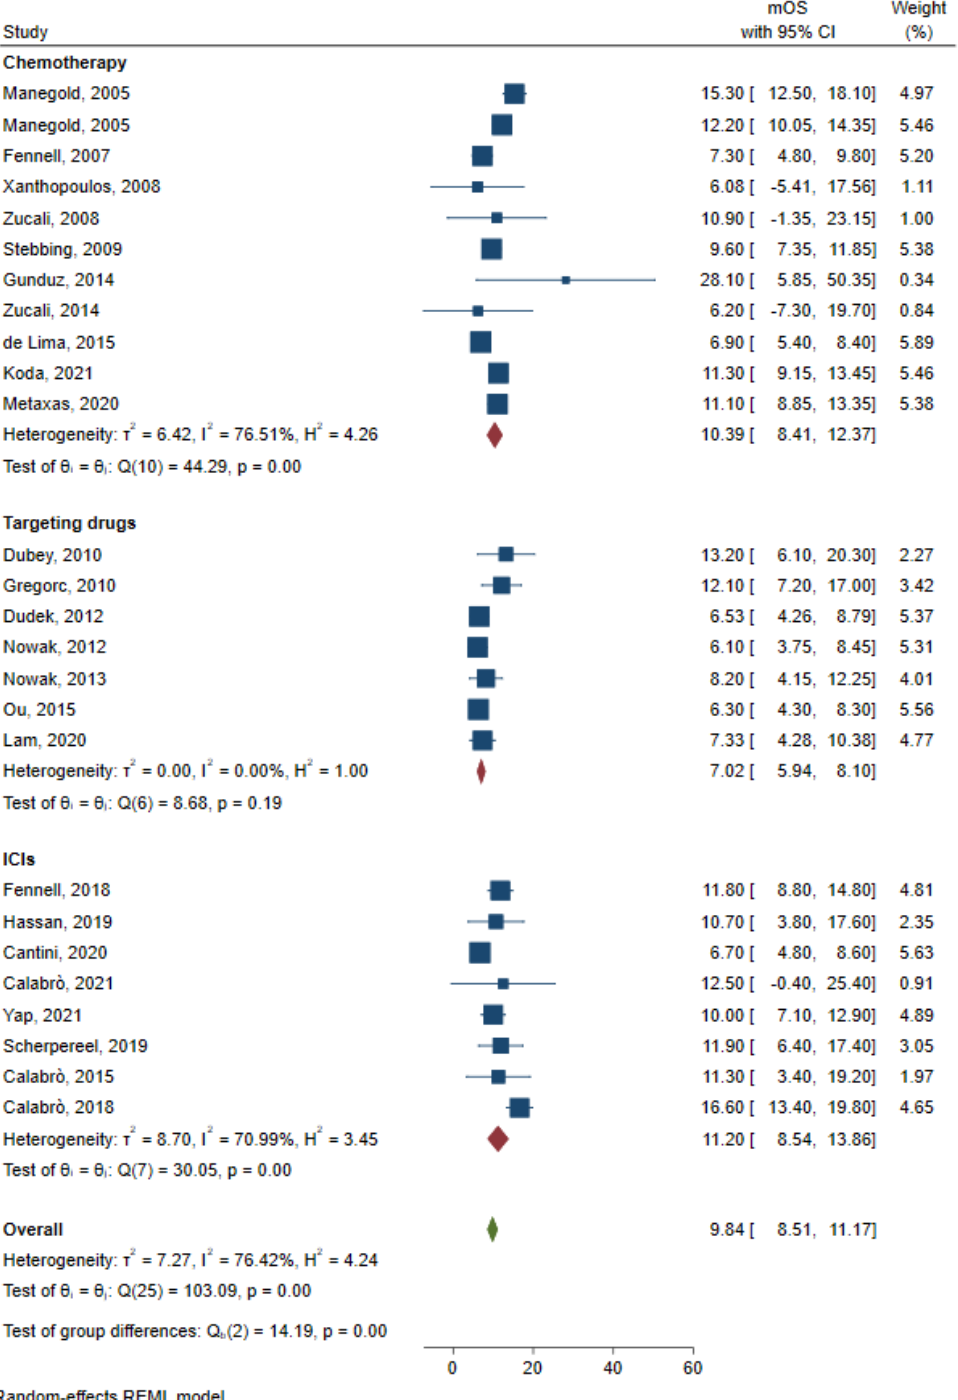
Figure 2. Pooled analysis of mOS for chemotherapy, ICIs, and targeting drugs [7 – 11,13 – 15,18,19,21 –